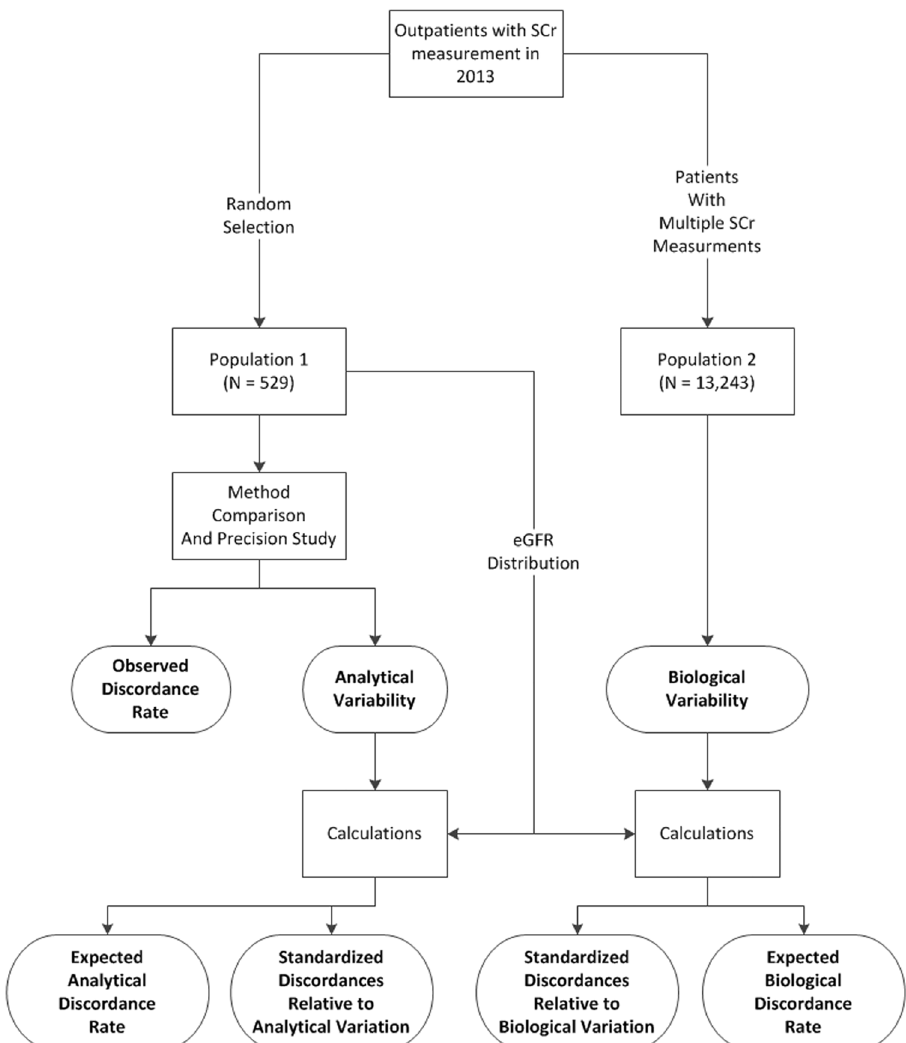
Fig 1. Overview of experimental design. We randomly selected 529 patient samples from outpatient samples that were submitted to the laboratory for SCr measurements (Population 1). This group of samples was used for the method comparison study and to evaluate the analytical precision of the Jaffe and enzymatic methods. We estimated biological variability in the outpatient population by identifying all outpatients who had at least two SCr measurements in 2013 (Population 2). This group contained 13,243 patients with a total of 42,195 SCr measurements. We evaluated the magnitude of discordances (standardized discordances) and the frequency of discordances (expected discordance vs observed discordance).